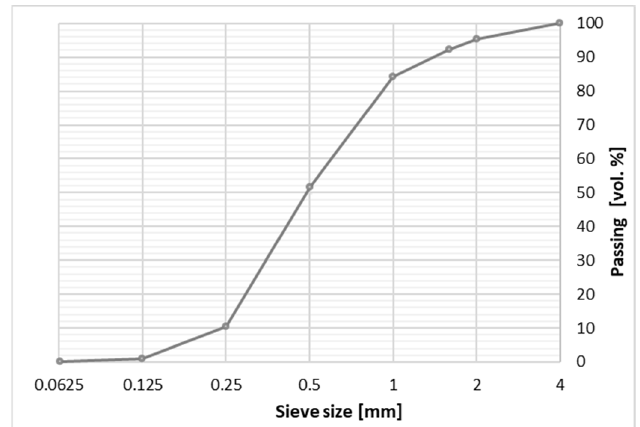
Figure 2. Grading of the natural aggregate.